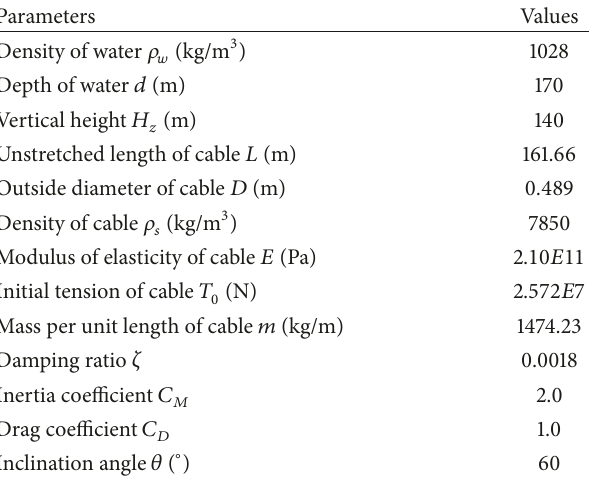
Table 1: Basic characteristics of the analysis